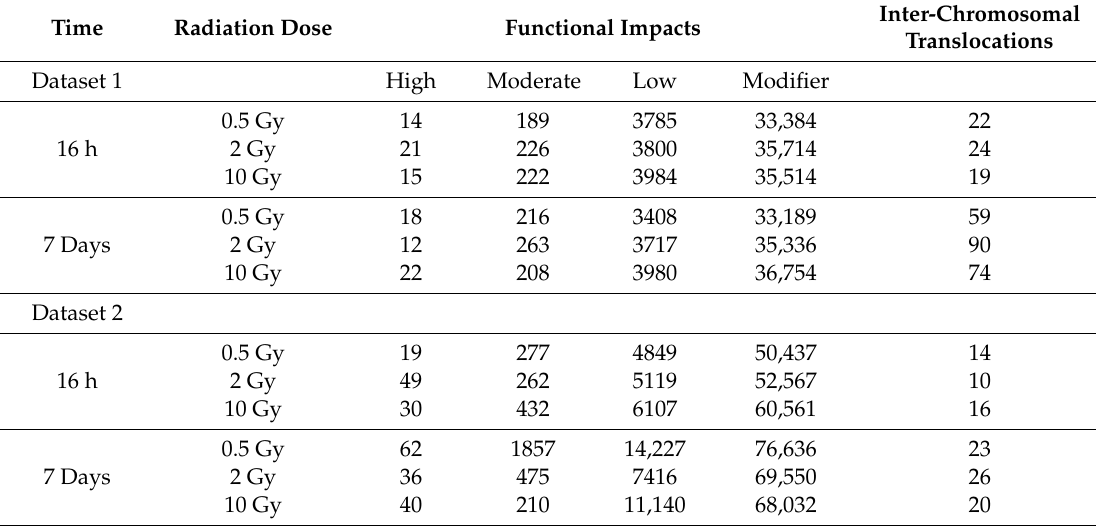
Table 1. Counts of IR-induced variants (sequence annotation with SNPE ff annotator) as well as translocations for all